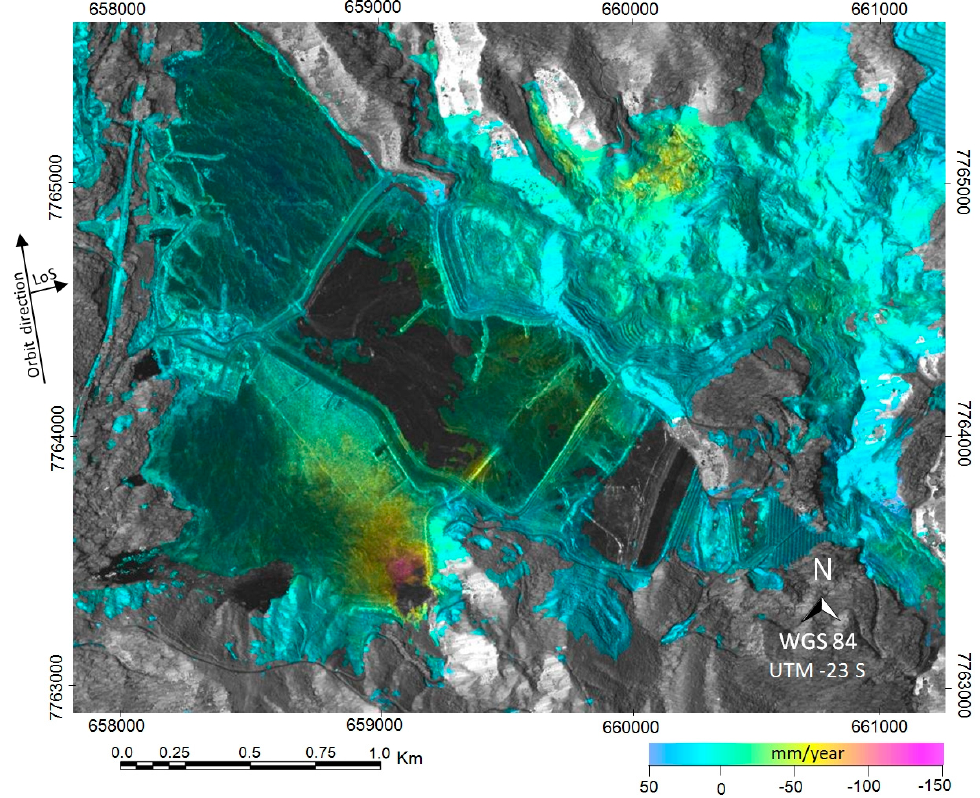
Figure 6. Displacement velocity map in LoS derived from SBAS analysis.